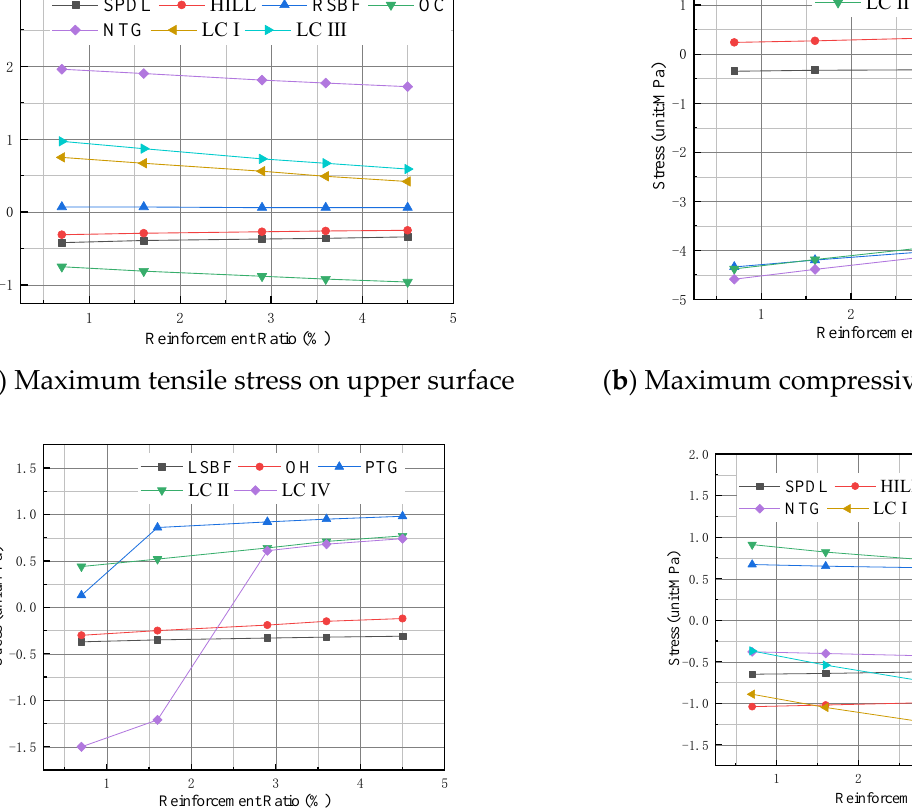
( c ) Maximum tensile stress on the bottom surface ( d ) Maximum compressive stress on the bottom surface Figure 13. Curve of maximum stress vs. reinforcement ratio of CLS. Figure 13. Curve of maximum stress vs. reinforcement ratio of CLS.